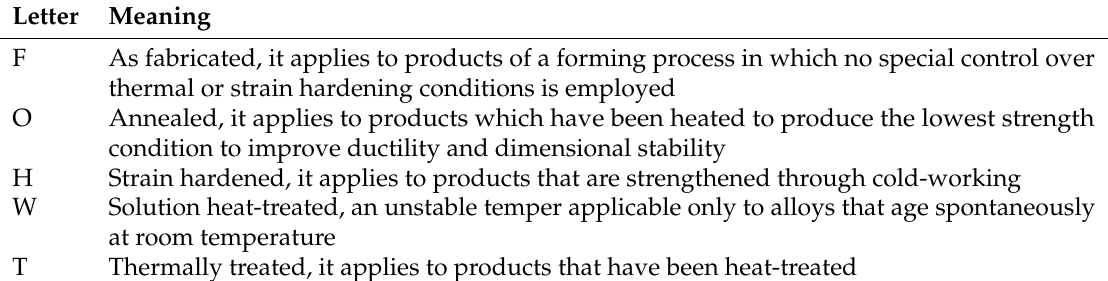
Table A3. Basic temper designation for aluminum alloys